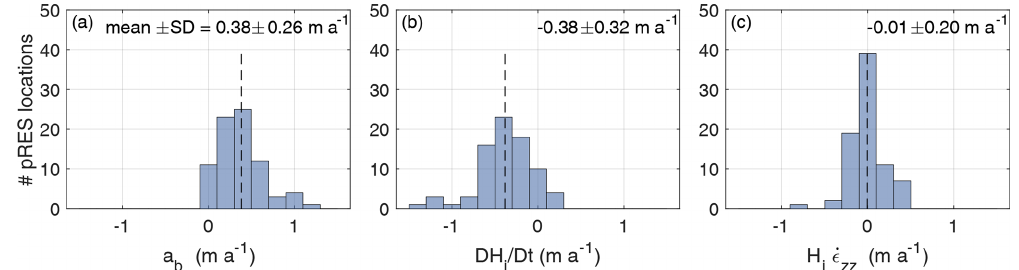
Figure 2. Distribution of pRES-derived results of (a) the basal melt rate a b , (b) the change in solid-ice thickness D H i / D t and (c) the dynamic change in solid-ice thickness H i ˙ ε zz . The numbers in the upper right corner state the mean value and the standard deviation